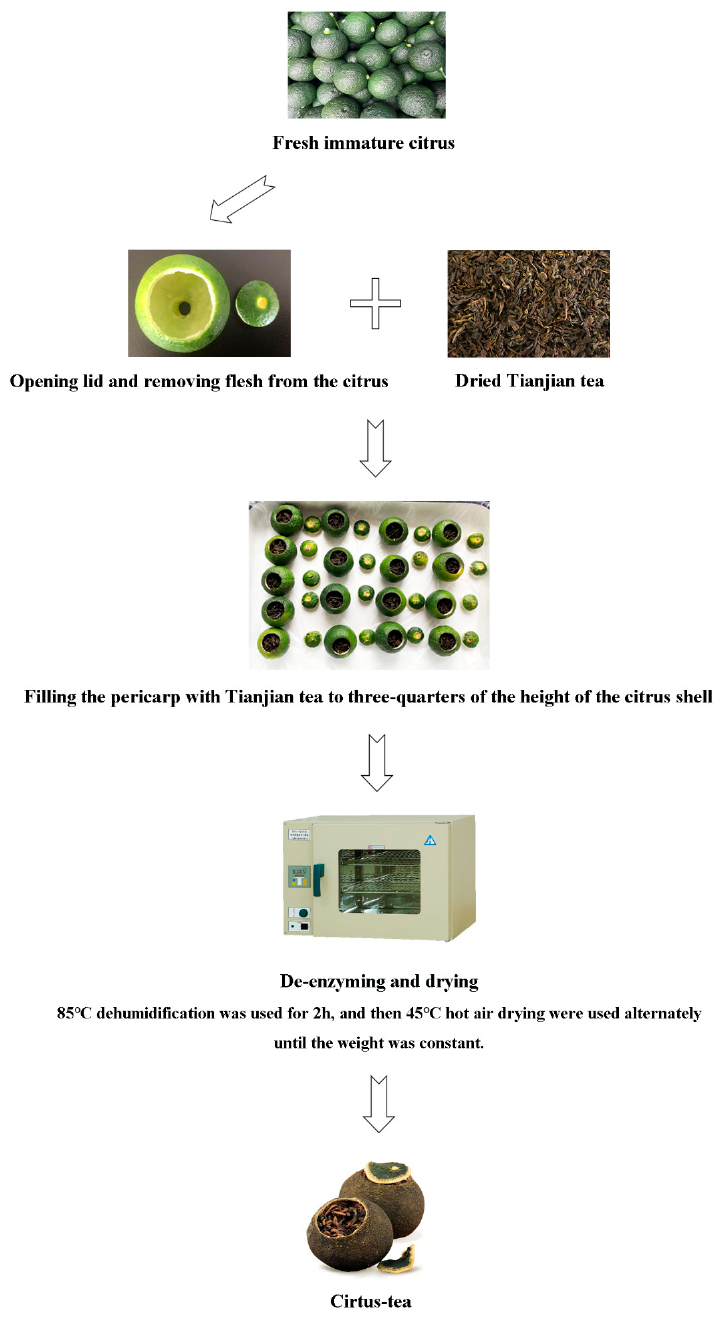
Figure 8. Manufacturing process of citrus-tea.